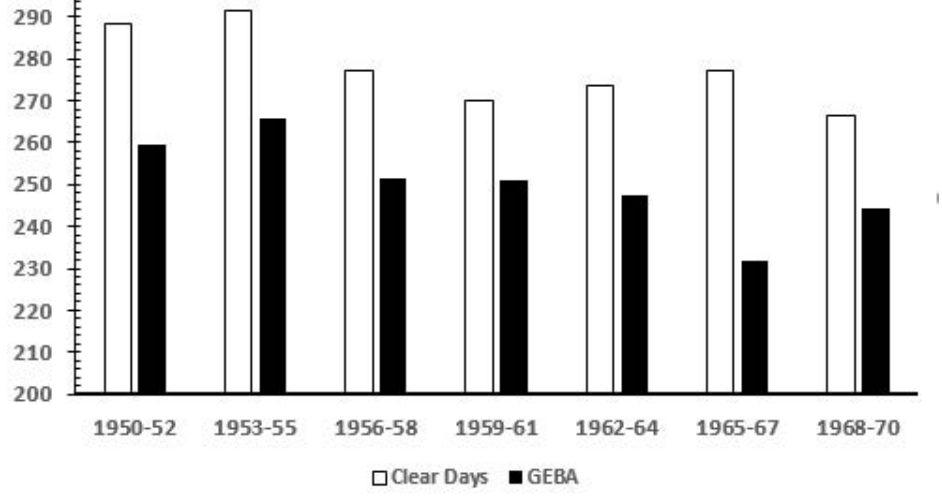
Figure 3. Three-year mean annual K ↓ (W/m 2 ). Clear days extracted from Figure 2 in [18] and GEBA data for all days.